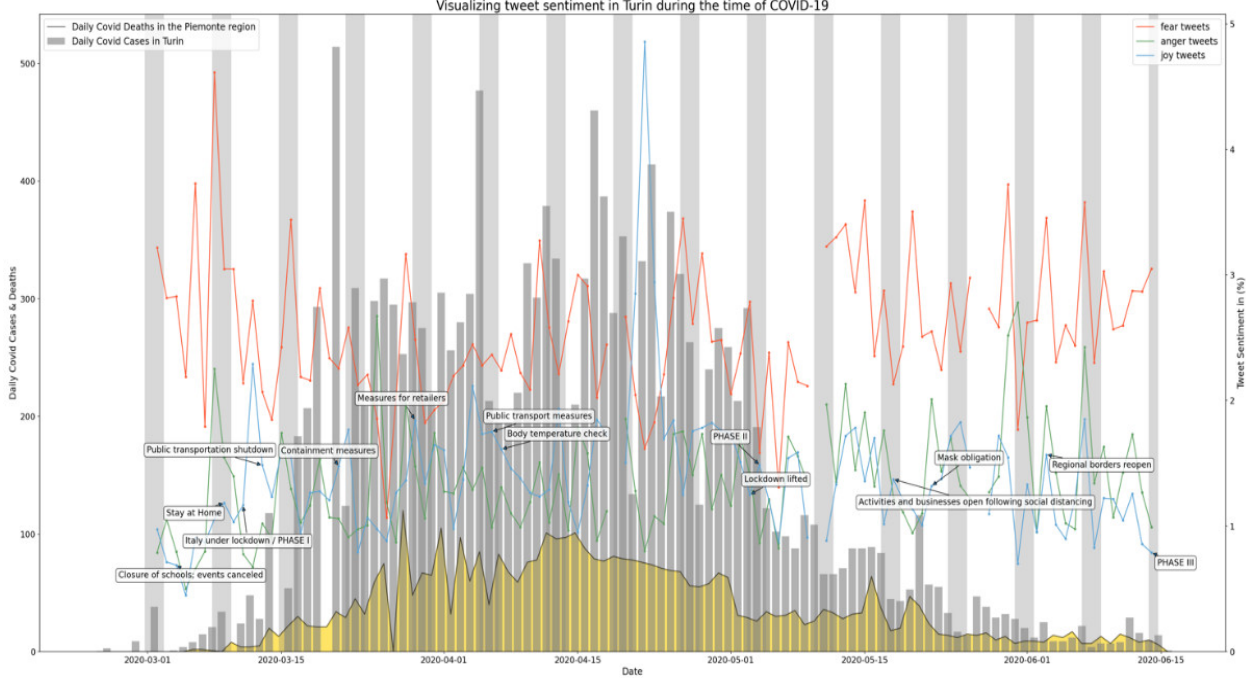
Figure A3. Visualizing Twitter sentiment in Turin during the time of